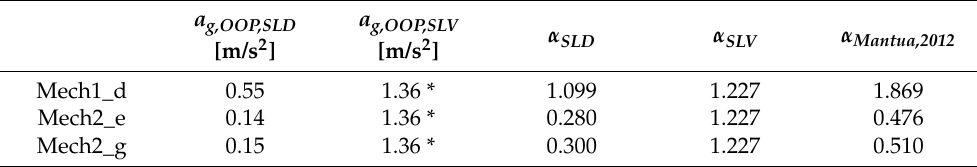
Table 1. Results for Macroelement 2.